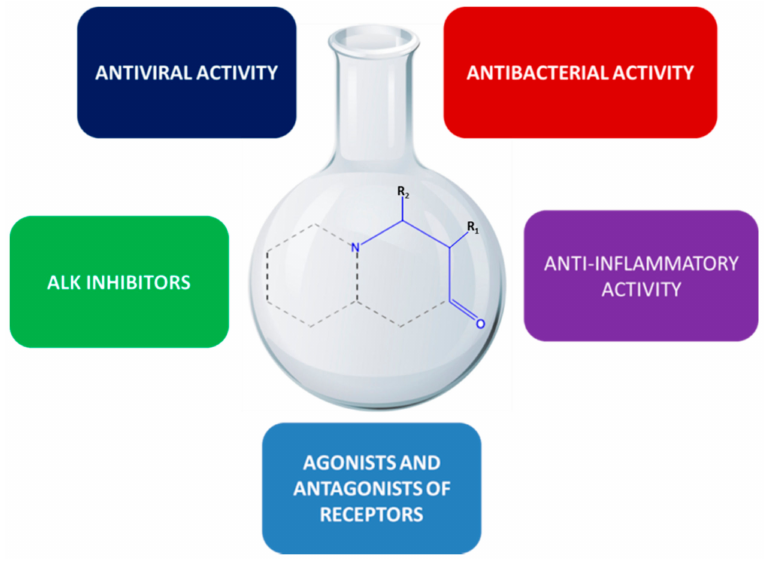
Figure 2. Schematic presentation of the biological activity of heterocycles with β -amino acid